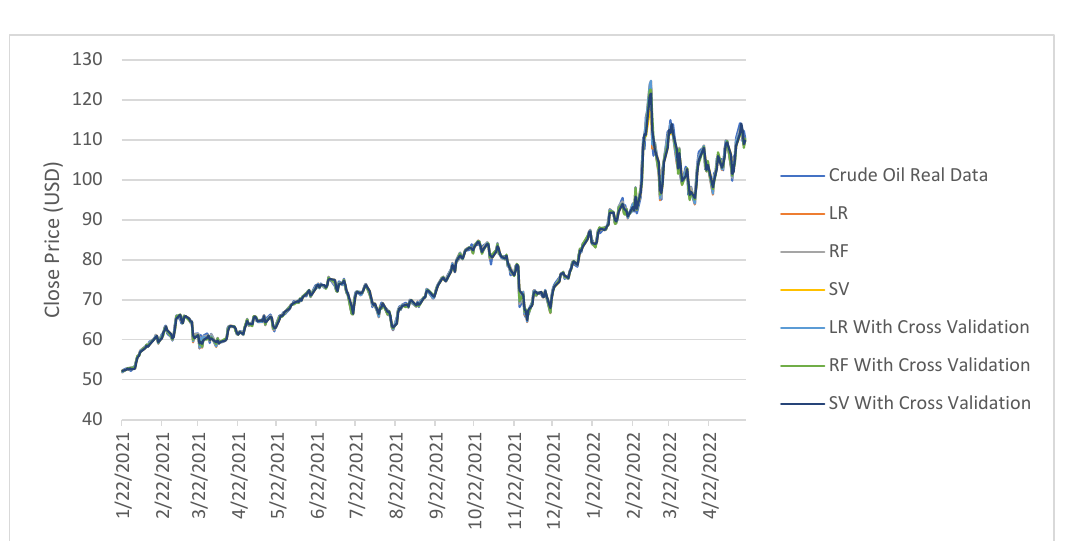
Figure 6. Results for eight months with the effect of COVID ‐ 19 for two years.